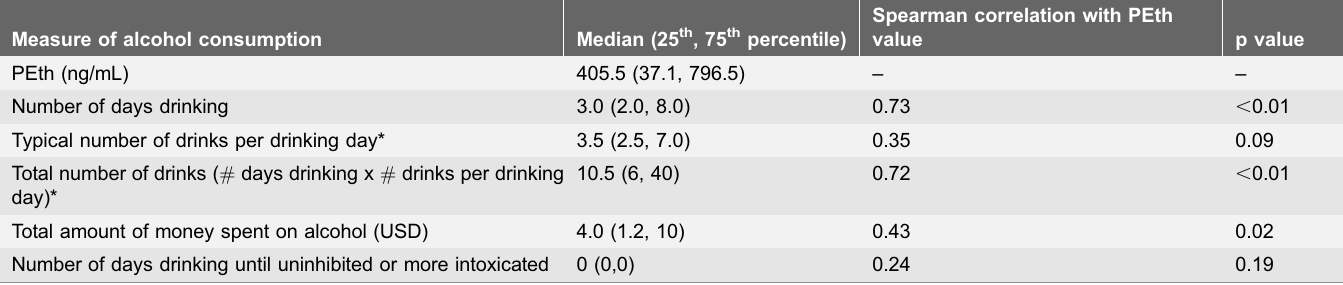
Table 5. Measures of alcohol consumption and correlations with PEth, among those reporting any alcohol consumption, prior 30 days (n 5